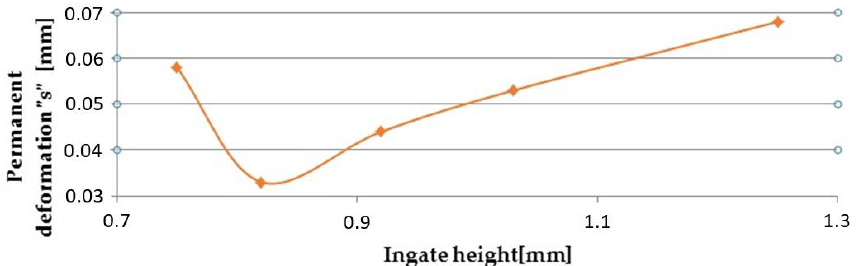
Figure 13. Relationship between permanent deformation and change of the ingate height. Table 8. Values of permanent deformation “s” in relation to change of the ingate height. Sample No.